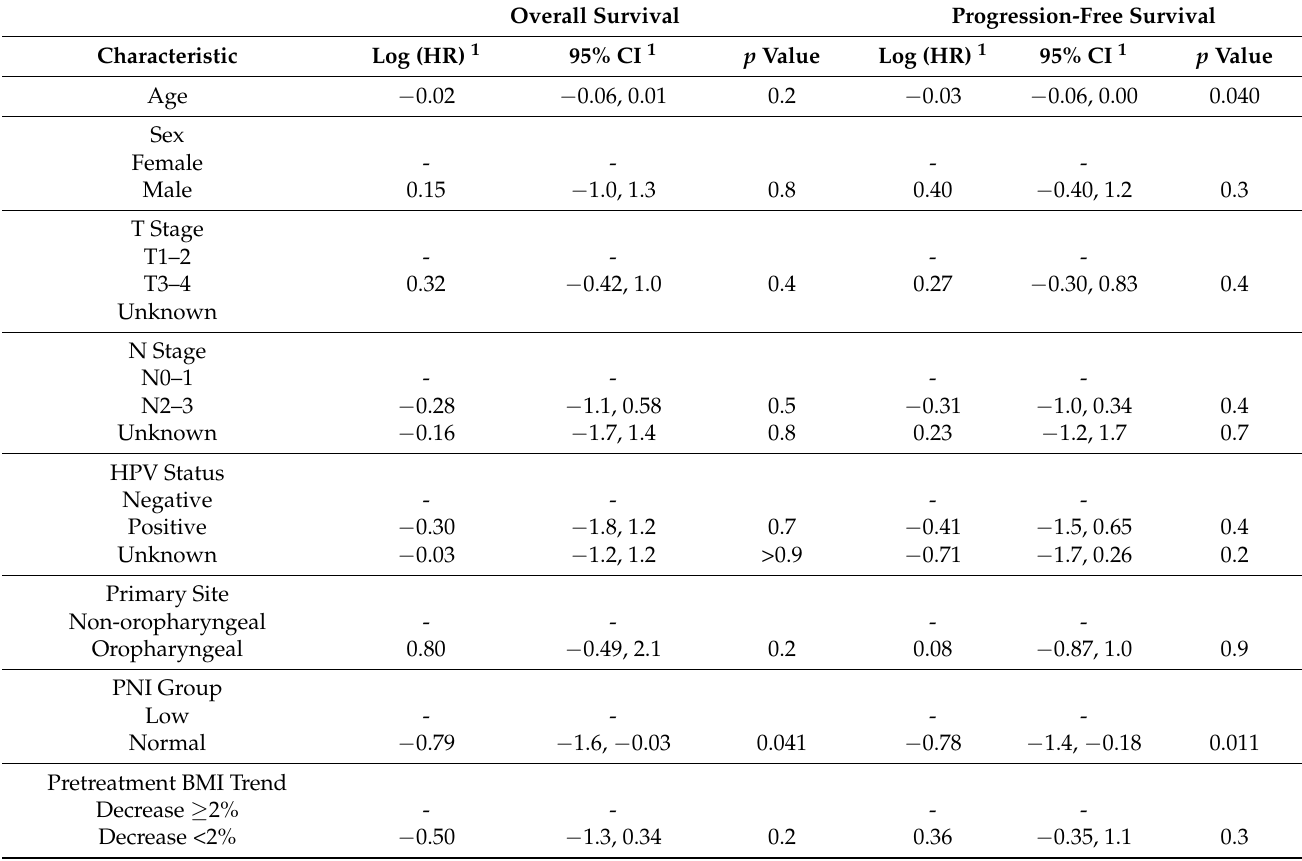
Table 3. Multivariate analysis of OS and PFS. Overall Survival Progression-Free